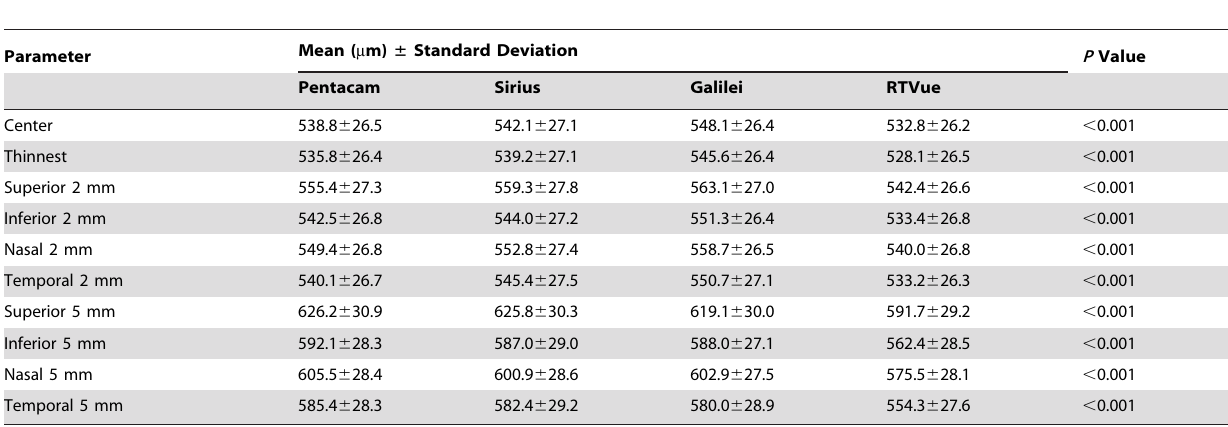
Table 1. Central corneal thickness, thinnest corneal thickness and midperipheral (2 and 5 mm diameter) corneal thickness in the superior, inferior, nasal, and temporal quadrants with the four investigated